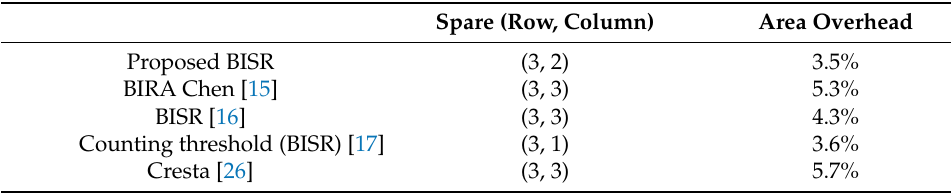
Table 13. Area overhead comparison and